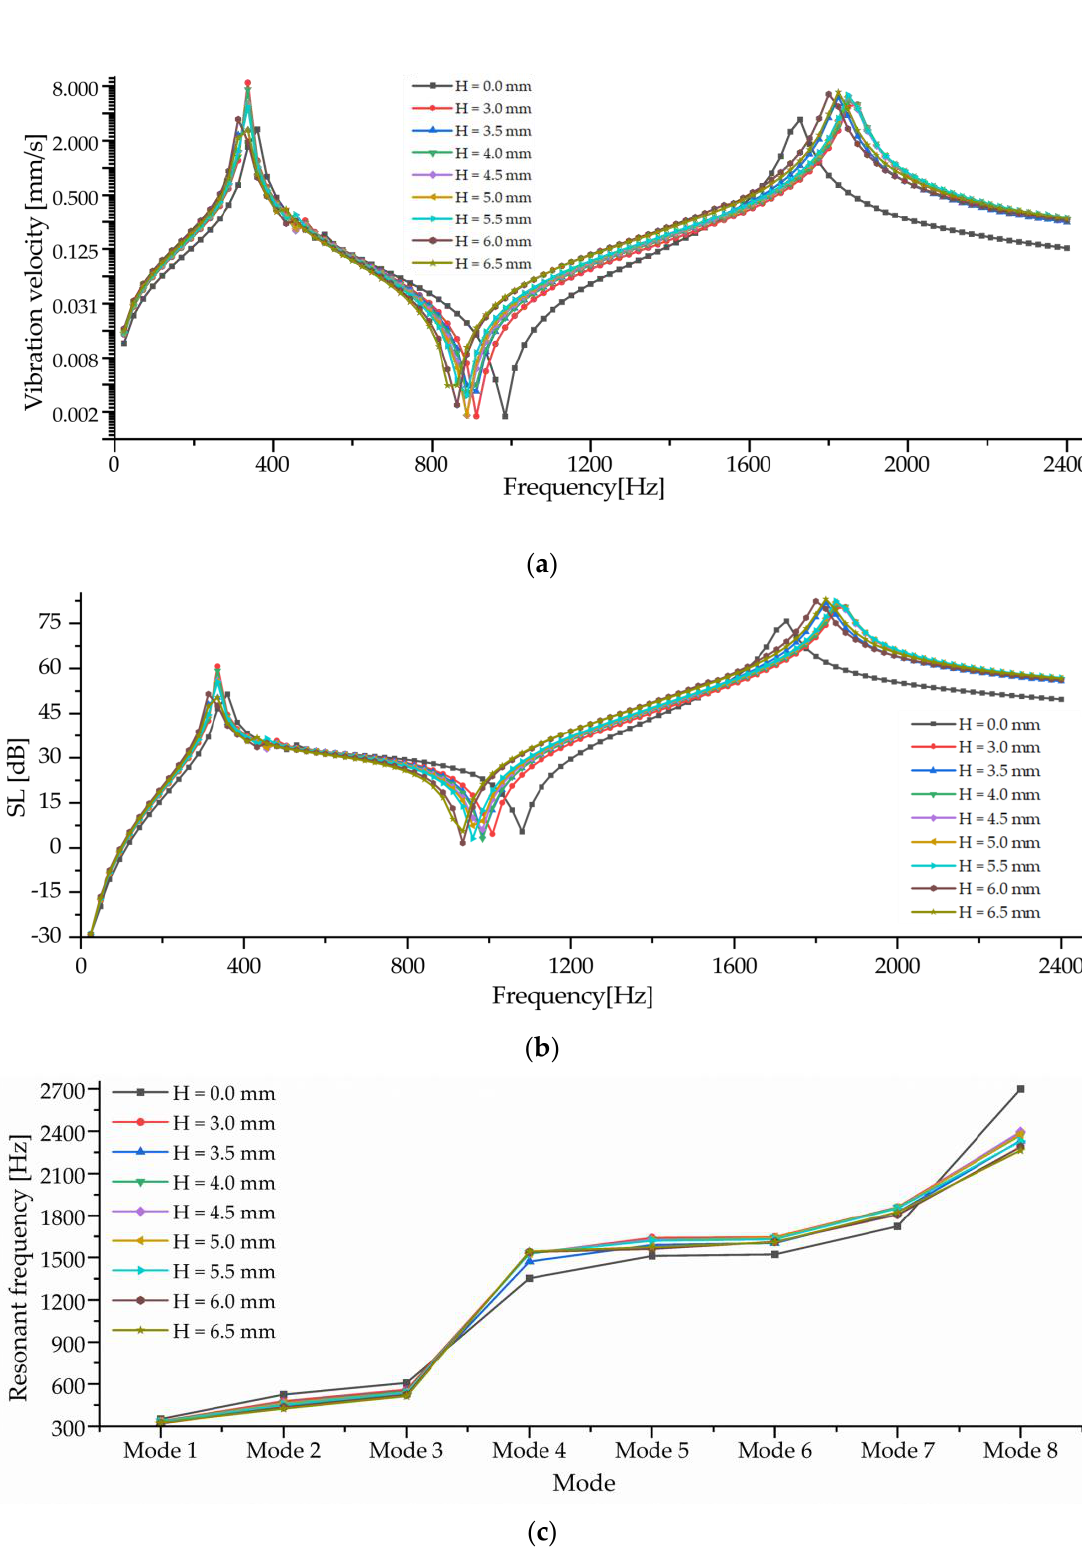
Figure 13. The influence of value H on the work panel. ( a ) Surface vibration velocity. ( b ) SL. ( c ) Resonance frequency.